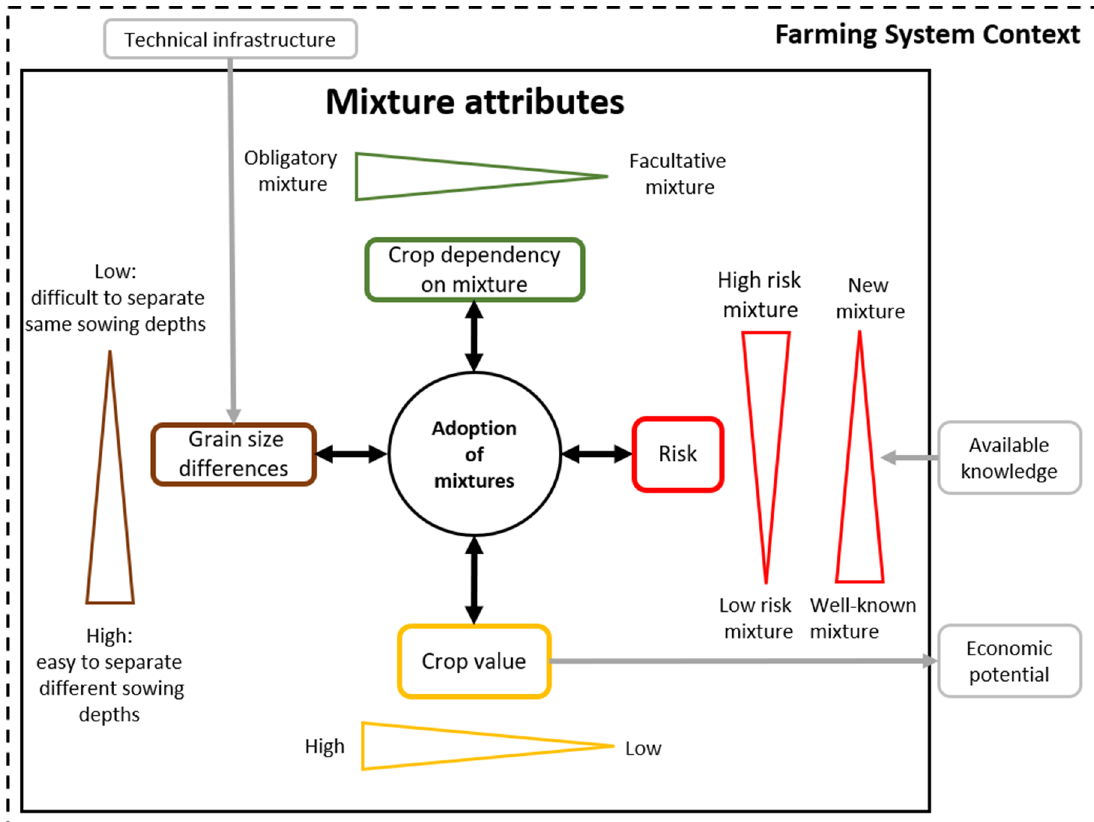
Figure 5. Social representation of mixture attributes and their influence on the adoption process in a farming system context, interpretatively reconstructed from the interviews with farmers.